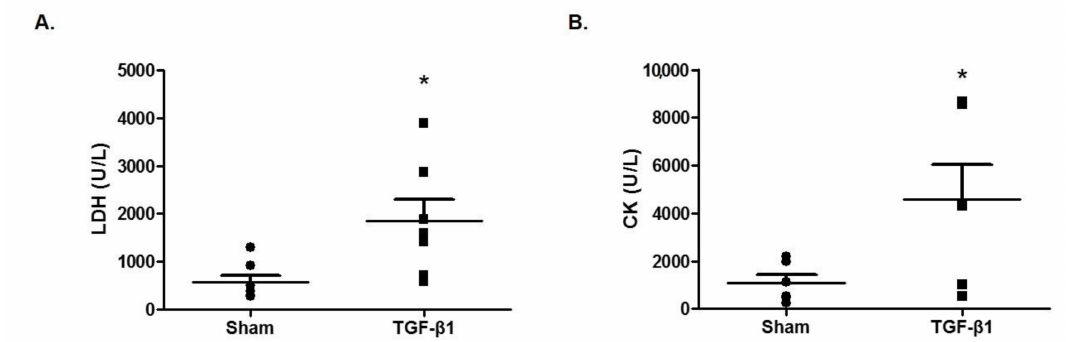
Figure 3. Effects of TGF- β 1 on lactate dehydrogenase (LDH) and creatine kinase (CK) in serum. The serum was isolated from C57BL/6 mice at 18 days after TGF- β 1 intracerebroventricular (i.c.v.) injection. The serum levels of ( A ) LDH and ( B ) CK were measured using a biochemical analyzer. Data are presented as mean ± SEM (N = 6). * p < 0.05 compared with the sham